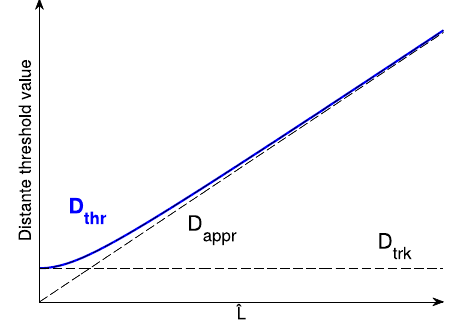
Figure 4. Adaptive distance threshold function D reference